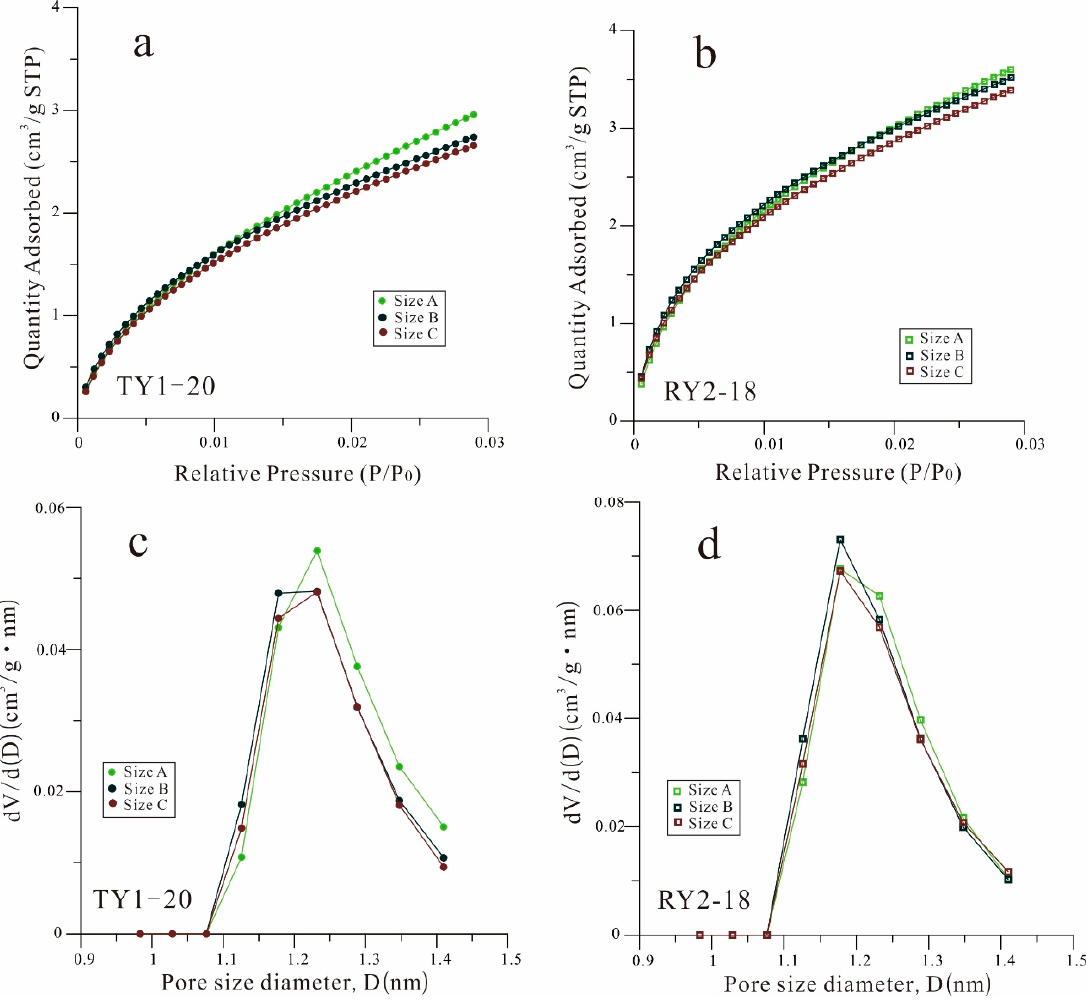
Figure 5. ( a , b ) CO 2 adsorption isotherms and ( c , d ) PSD for the TY1-20 and RY2-18 samples with three different particle sizes.